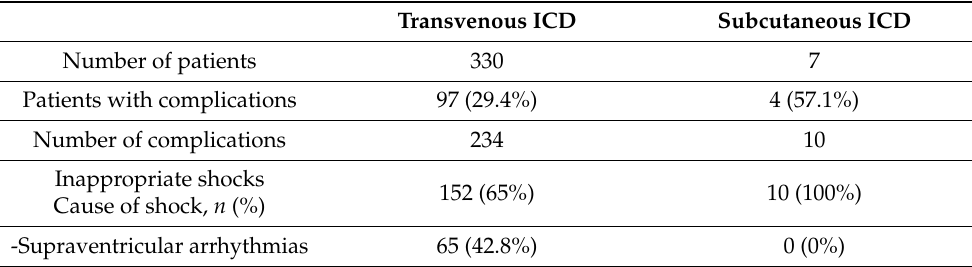
Table 3. Comparison of complications between transvenous ICD and subcutaneous